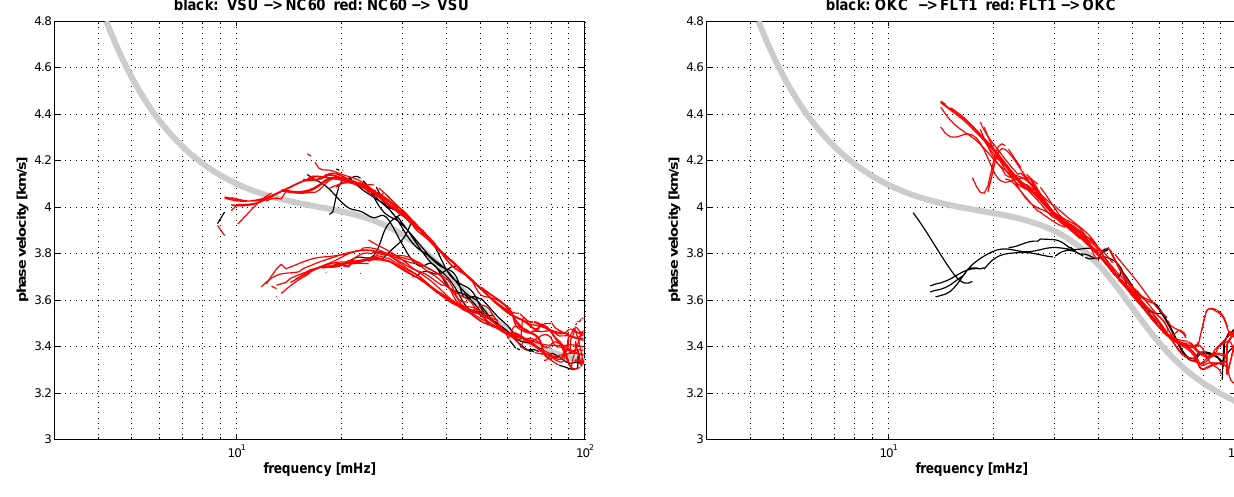
Fig. 2a. Automated phase velocity measurements between station NC602 in southern Norway and VSU in Estonia. Curves show sig- nature of a polarity issue with π offset from the expected reference curve.